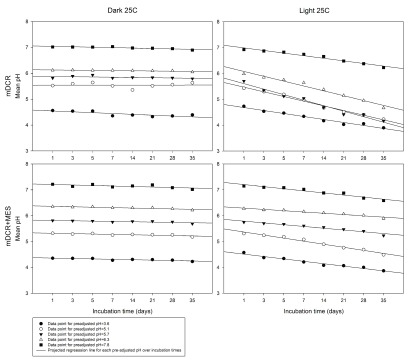
Media pH changes over incubation times from mDCR and mDCR+MES media incubated under dark and light conditions.Medium pH was preadjusted to 3.6, 5.1, 5.7, 6.3, and 7.8 prior to adding 7 g/L of agar, MES and autoclave. Medium was incubated in a growth chamber with full light or darkness at 25°C until it reached incubation requirement. Post-autoclaving pH was recorded using a pH meter at each incubation time. Data points represent mean pH (n=5 for each data point), and were fitted with linear regression lines. Please see
Dataset 1 for the raw data.